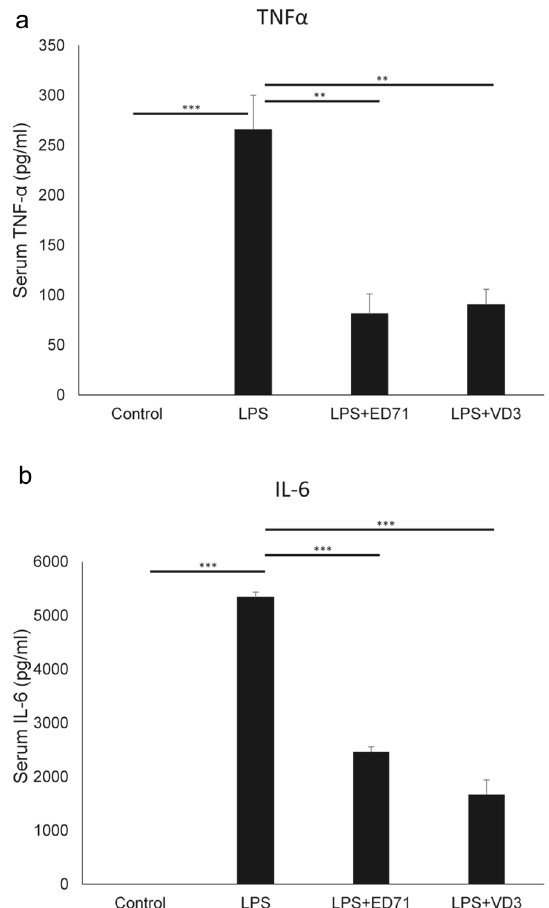
Figure 5. ED71 or VD3 treatment antagonizes induction of inflammatory cytokines by LPS. C57BL/6 mice were intraperitoneal injected with LPS (150 µg/kg). In ED71 + LPS group and VD3 + LPS group, C57BL/6 mice were pretreated with ED71 (0.05 mg/kg) or 1,25(OH) 2 D 3 (VD3) (0.05 mg/kg) 24 h and 1 h before LPS injection. Maternal serum was collected 2 h after LPS injection. Serum TNF-α ( a ), IL-6 ( b ) were measured using ELISA. All data were expressed as means ± SD of six samples from 5 different mice (n = 5 each, **P < 0.01; ***P < 0.001). Representative data are shown of at least two independent and identical experiments, each with n =